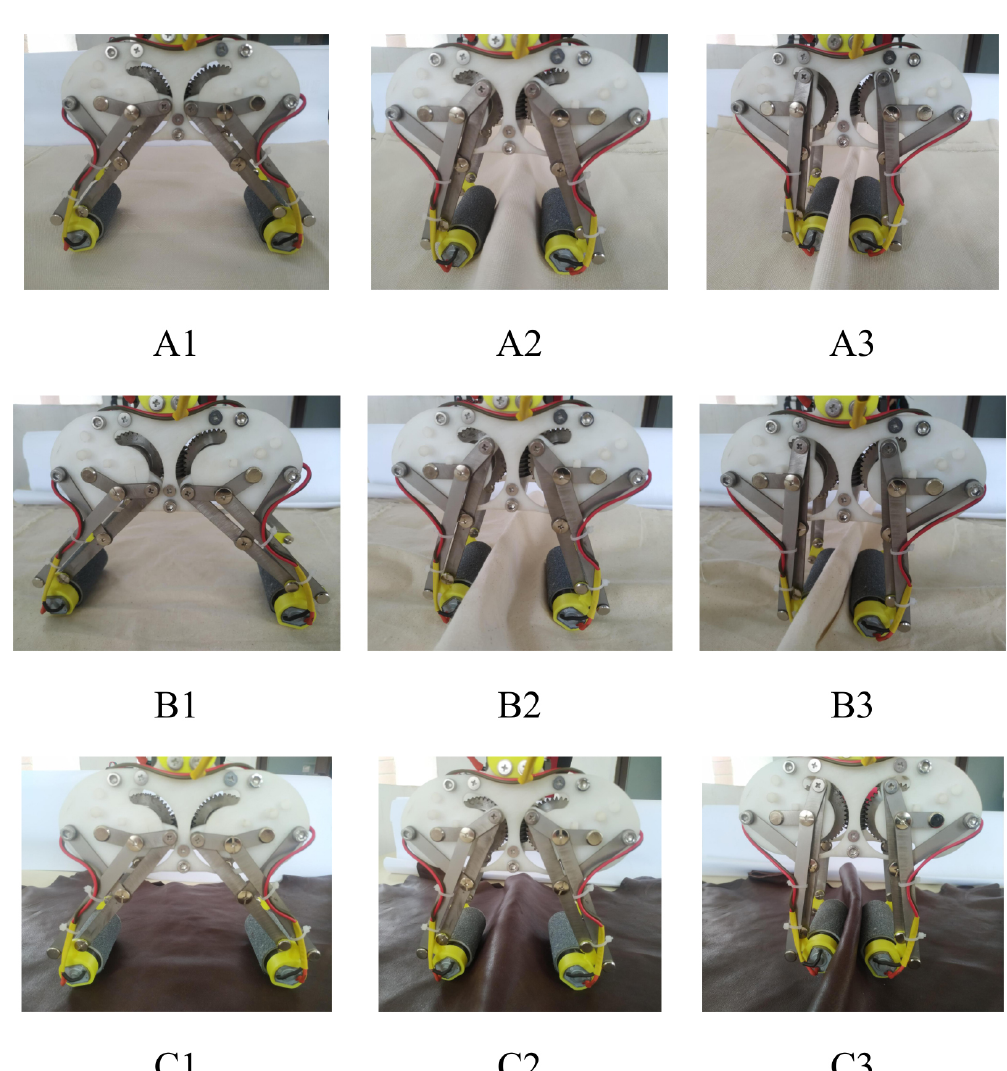
Figure 15. Experiment of fabric grabbing in multi-layer tiled